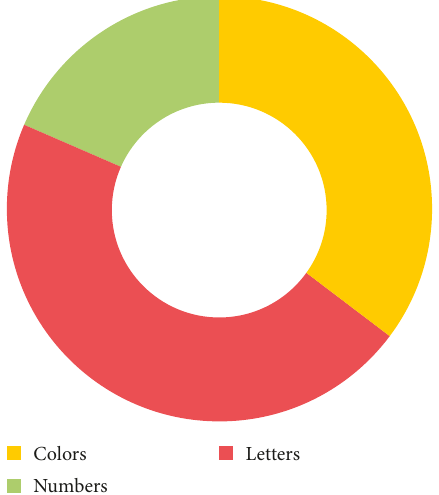
Figure 10: Visual representations of percentages of responses in Question